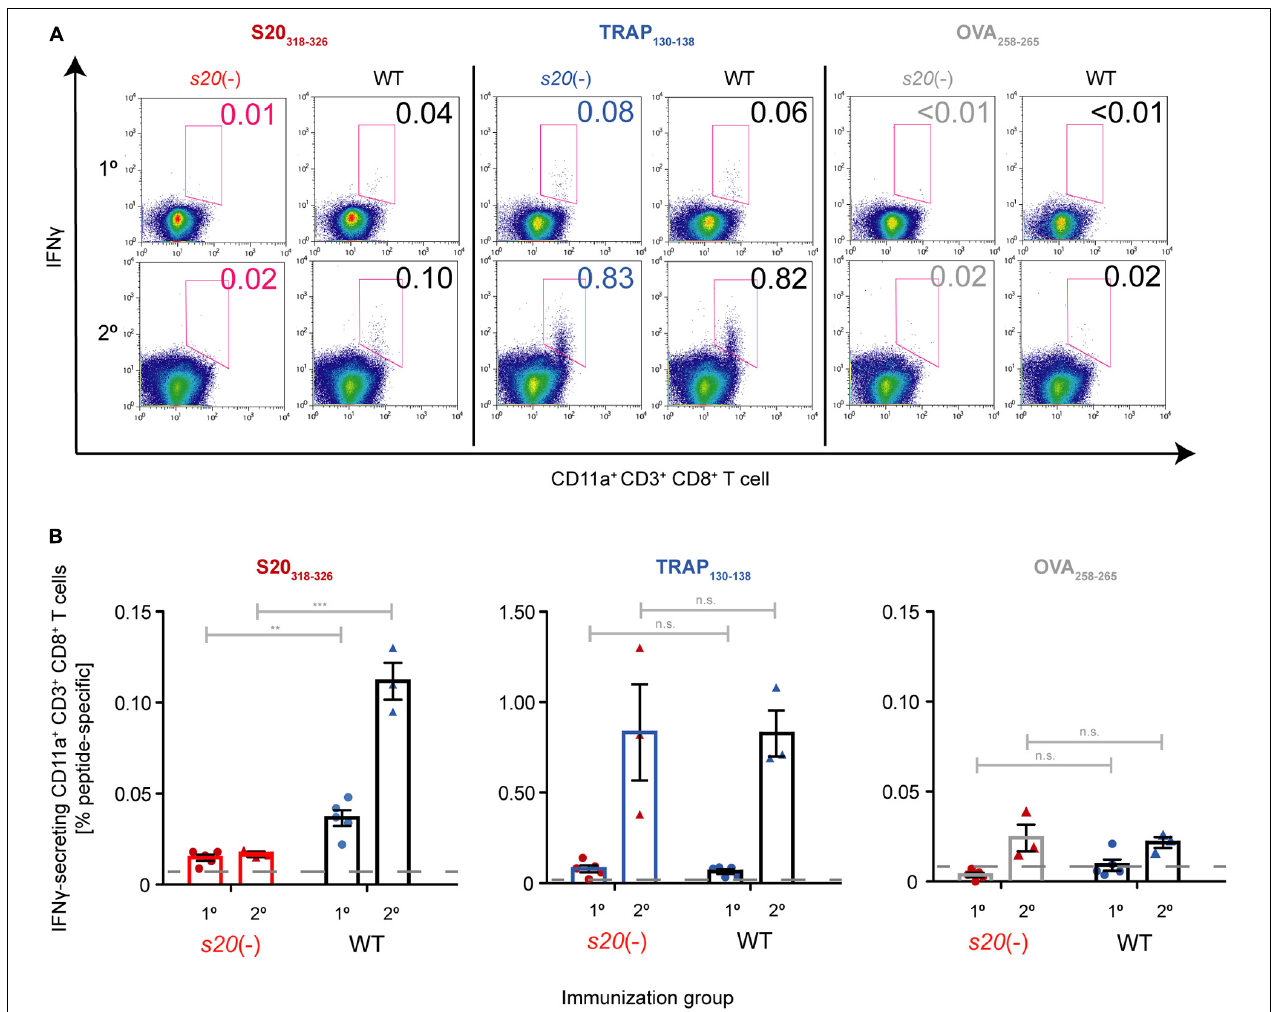
FIGURE 5 | Absence of S20 318 - 326 -specific splenic CD8 + T cells in s20 (-)-immunized mice. B6 mice were immunized once (1 ◦ ; n = 5 each) or twice (2 ◦ ; n = 3 each) with s20 (-) (red) or WT (black) attenuated sporozoites. Peptide-specific splenic CD8 + T cell responses were quantified after restimulation by intracellular staining 11 or 7 days later, respectively. (A) Representative FACS plots showing the gating strategy to identify IFN γ -secreting CD11a + CD3 + CD8 + T cells. The percentage of activated IFN γ + CD8 + T cells among total CD8 + T cells after stimulation with either S20 318 - 326 (red), TRAP 130 - 138 (blue), or unrelated OVA 258 - 265 (gray) peptide is indicated. (B) Quantification of activated, IFN γ + CD11a + CD8 + T cells among total CD8 + T cells after stimulation with either S20 318 - 326 (red), TRAP 130 - 138 (blue), or unrelated OVA 258 - 265 (gray) peptide. Shown are mean percentage ( ± SEM), n = 1. Striped lines represent baseline responses from peptide-restimulated splenic cells of naïve mice. n.s.,non-significant; ** p < 0.01; *** p < 0.001 (Unpaired t